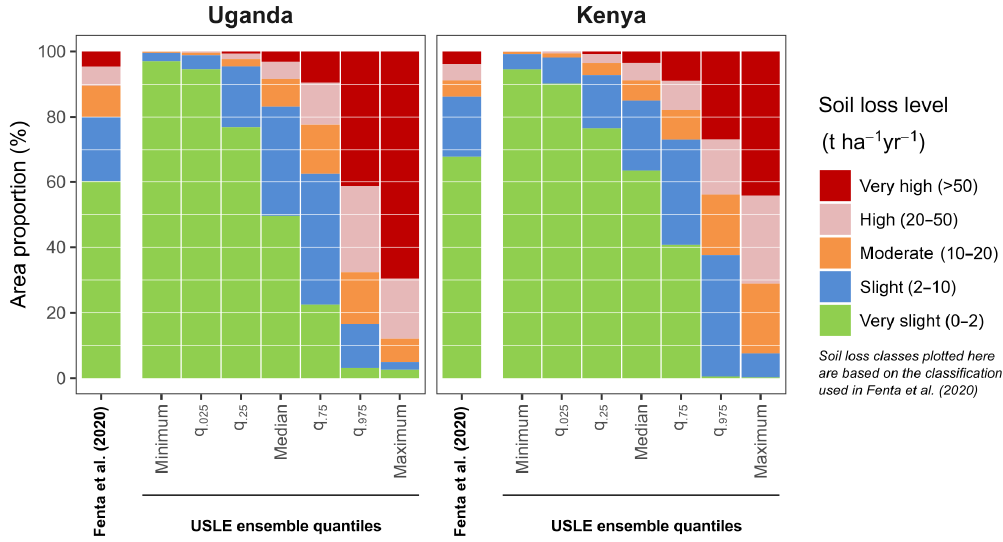
Figure 8. Comparison of the proportions of the areas in Kenya and Uganda that are summarized with different soil loss levels. The comparison shows the results reported in Fenta et al. (2020) to the results of the 972 USLE model realizations. The analyzed quantiles represent the soil loss quantiles in each grid cell that result from the USLE model ensemble. For the comparison the soil loss levels applied in Fenta et al. (2020) were